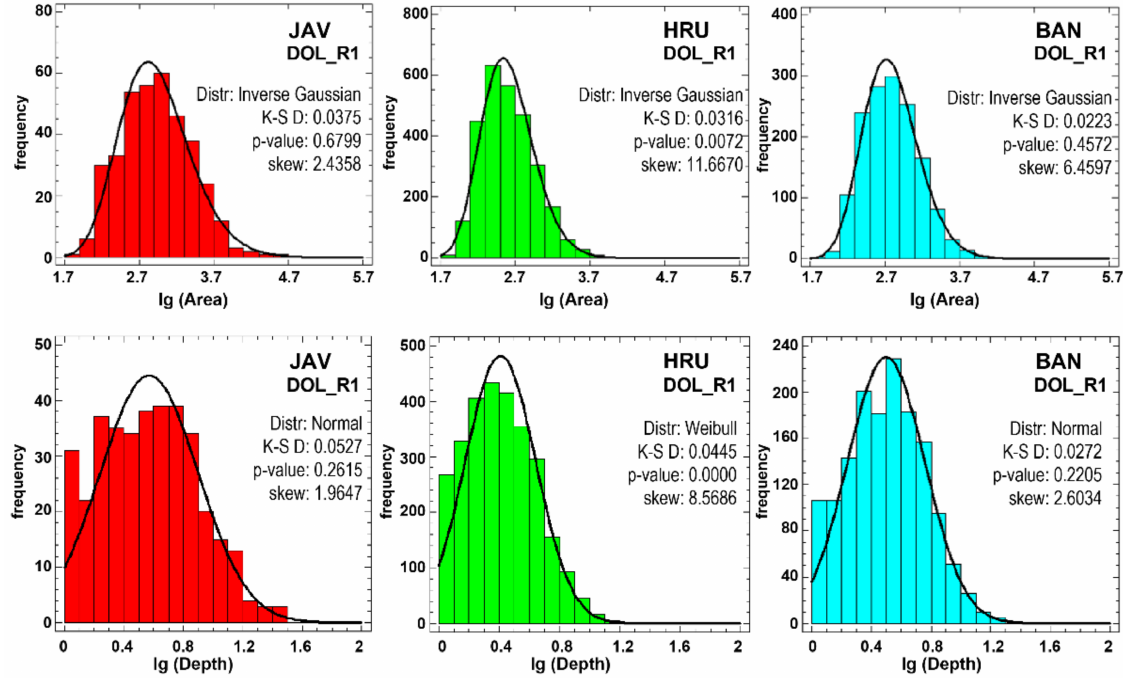
Figure 8. Empirical distributions and fitted theoretical distributions of doline properties (area and depth). Note that feature properties are logarithmically transformed on the x-axis. JAV: Javorniki; HRU: Hrušica; and BAN: Banjšice. K-S D refers to the D-value of the Kolmogorov–Smirnov tests. p -values higher than 0.05 testify that the fitted distribution cannot be rejected. Skew refers to the standard skewness of the